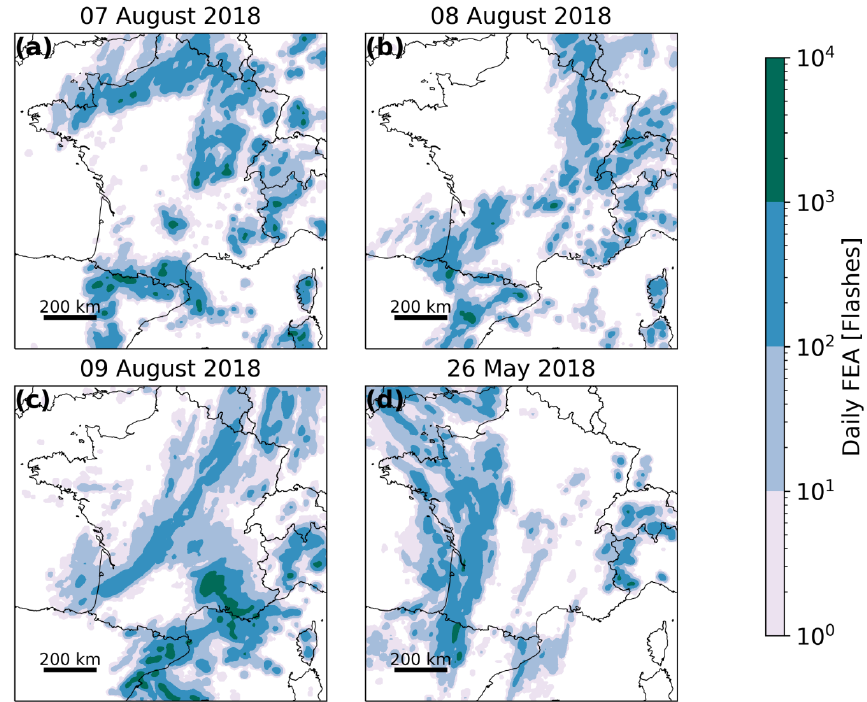
Figure 5. Daily FEA for (a–c) 7, 8 and 9 August 2018 and (d) 26 May